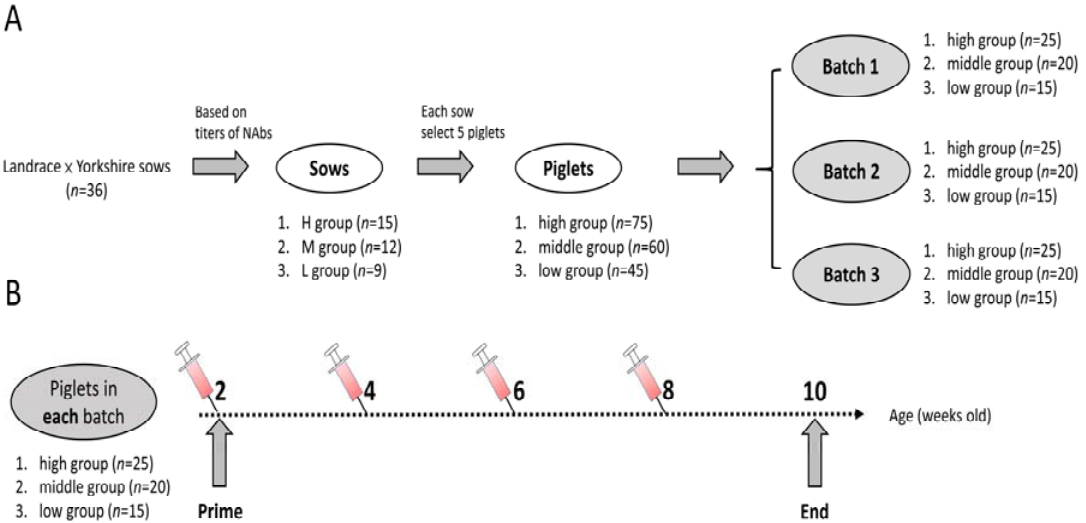
Figure 1. Schematic diagram of experimental arrangement ( A ) and protocol ( B ). Piglets ( n = 180) in three different groups were randomly separated into three batches consisting of equal numbers ( n = 60) and blooded at 2, 4, 6, 8 weeks of age.